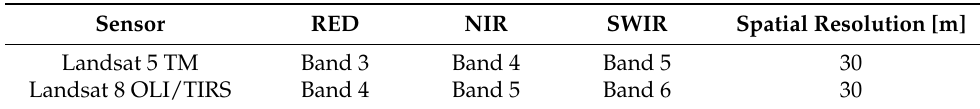
Table 2. Input data for the calculation of NDVI and